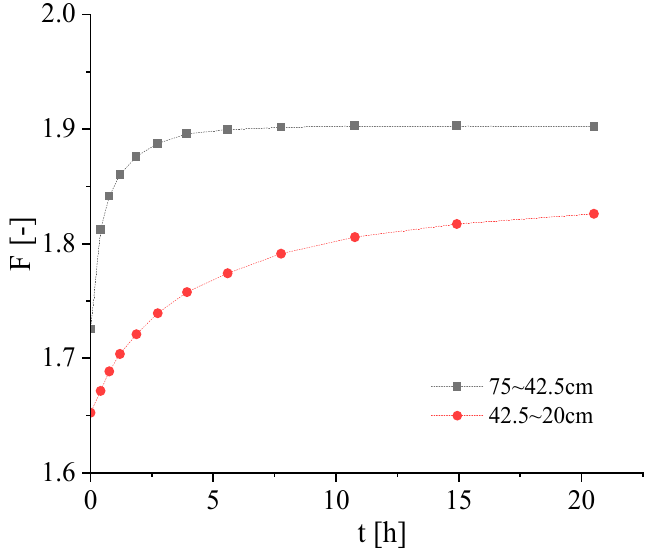
Figure 11. Changes in slope stability with time at different initial water levels after water level sta- bilization.